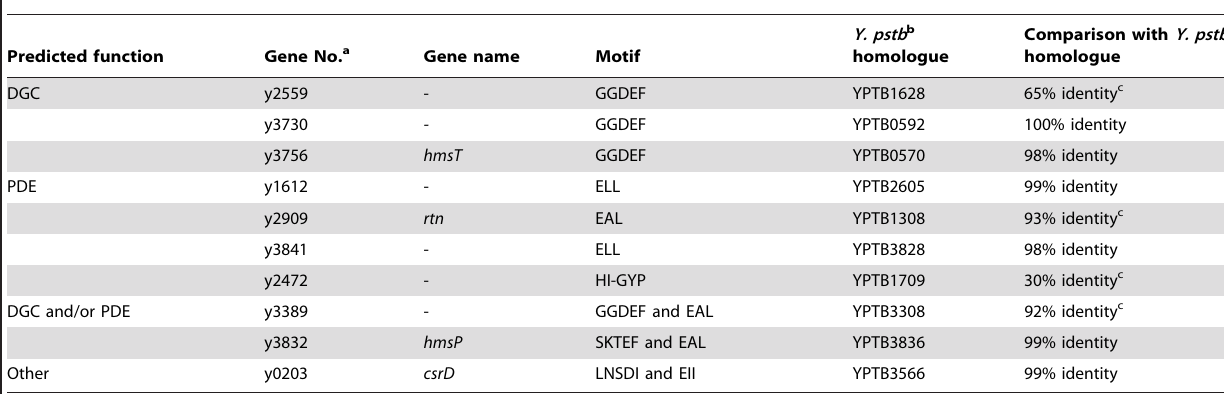
Table 1. Known and putative DGC and PDE proteins in Y. pestis KIM6 + .